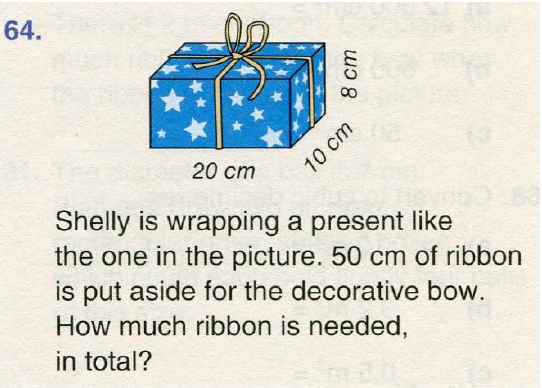
Figure 2. Example of combined form from Laskutaito textbooks.